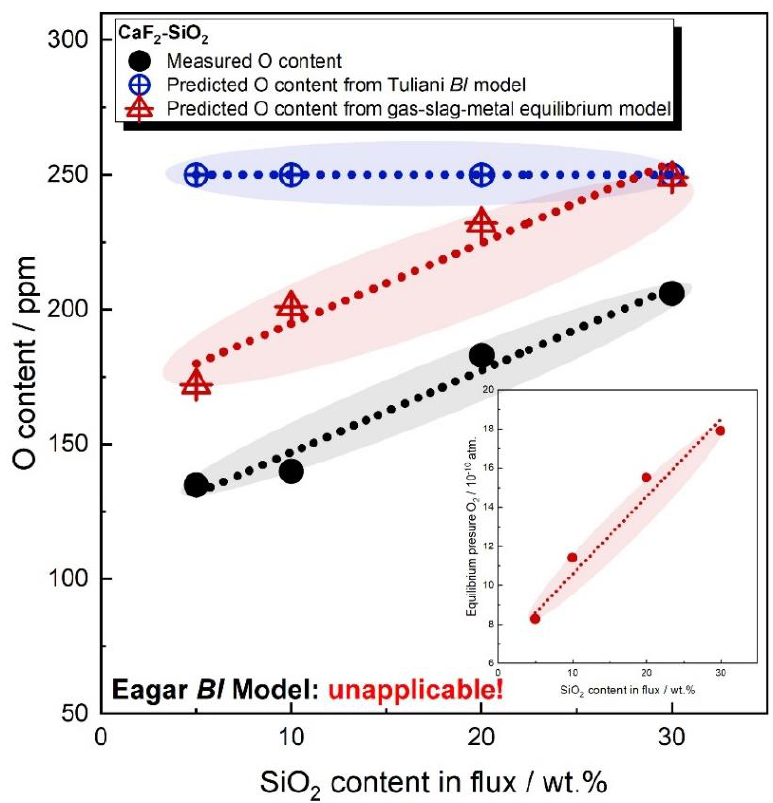
Figure 8. WM O content and equilibrium p O2 as a function of SiO 2 content in flux.